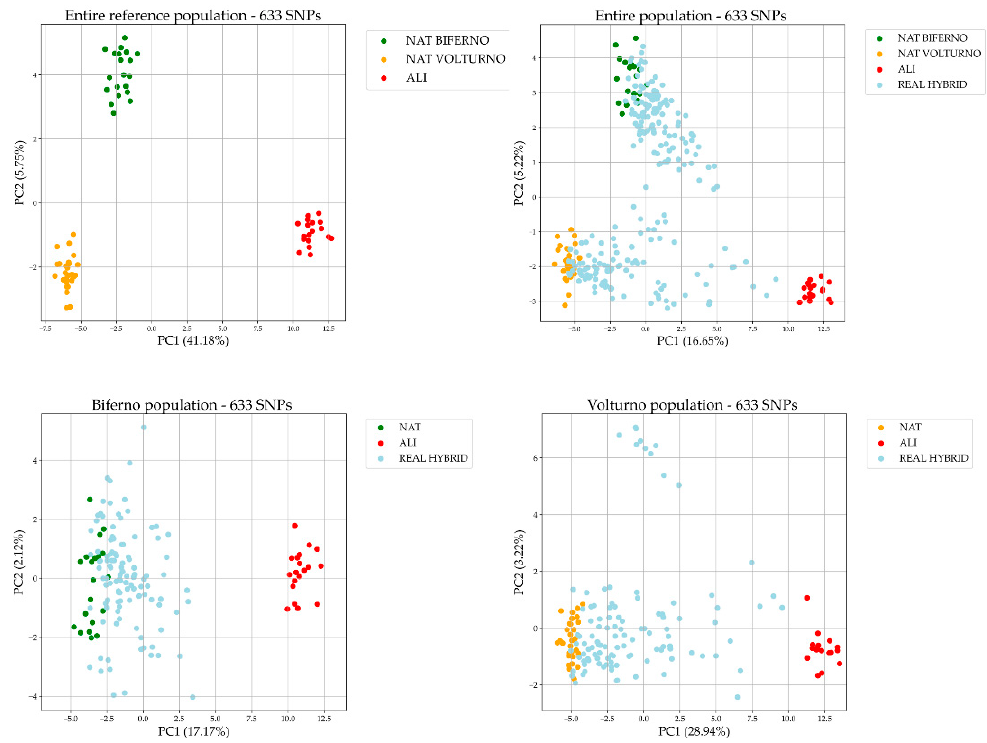
Figure 1. PCA obtained using the full SNPs set on reference and entire populations, encompassing non-admixed native and alien trout samples. In green and orange are reported the non-admixed native split by rivers and in red the alien samples, respectively. In brackets the percentage of variance explained by each component is reported. Table 1. Number of SNPs shared between pairs of SNP panels determined with the seven different methods reported in this study (in the diagonal, the 96